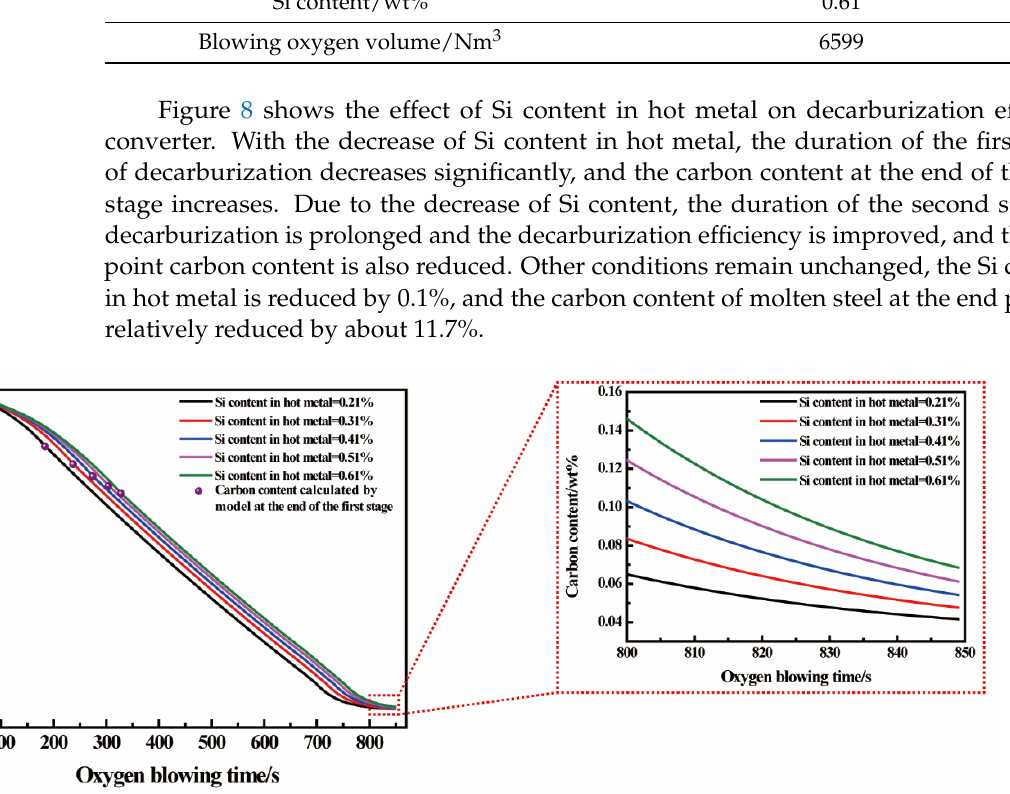
Figure 8. The effect of Si content in hot metal on decarburization effect of converter.